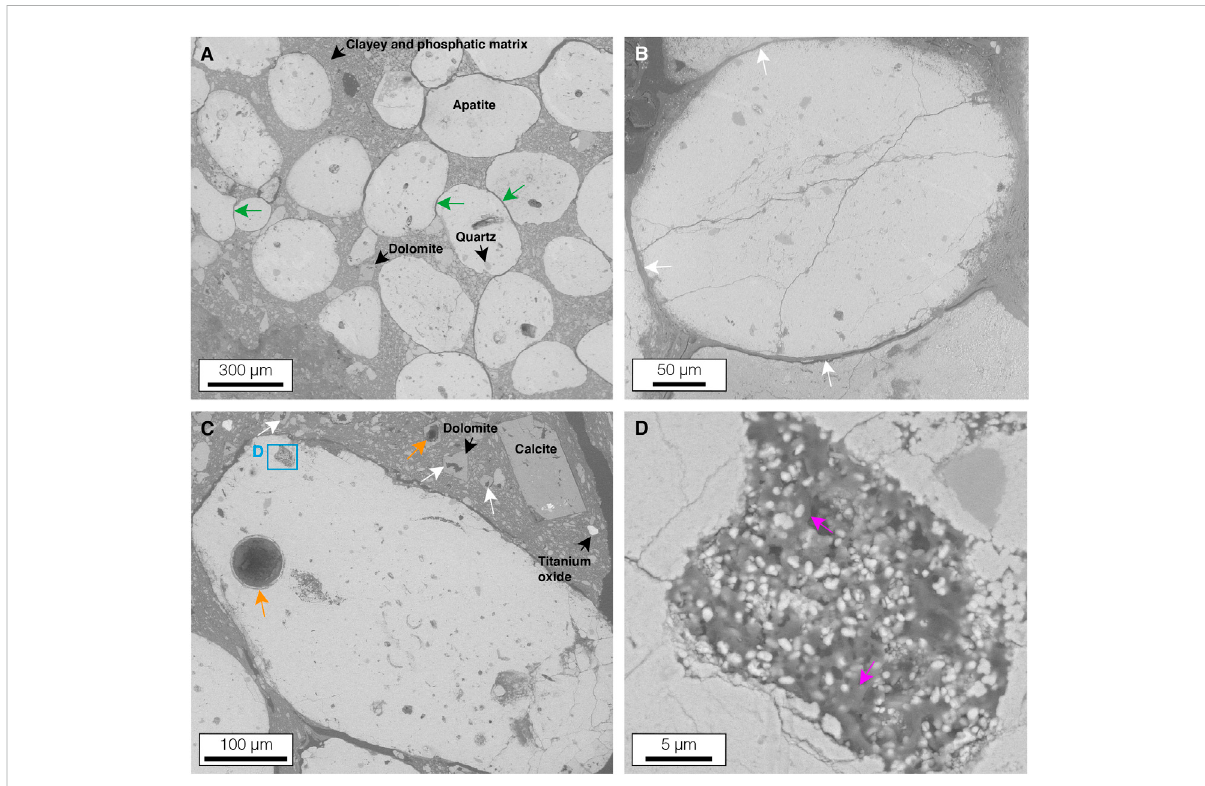
FIGURE 3 SEMimagesinback-scatteredelectronmodeofAmizmizphosphoritesfromtheMoroccanHighAtlas. (A) Thephosphategrainsareembedded in a dominantly clayey matrix in association with carbonate minerals. The P-rich grains experienced a weak to moderate degree of compaction as shown by the concavo-convex grain contacts (green arrows). (B) The clayey matrix is squeezed between phosphate peloids due to mechanical compaction (arrows). (C) Large and irregular phosphate peloid with numerous inclusions of quartz and fragmented shells. Orange and white arrows indicate traces left by in situ geochemical measurements and secondary dissolution features of rhombohedral dolomite, respectively. (D) Close up of image (C) . Micrometric phosphate crystallites surrounded by a thin clayey structure within the peloid